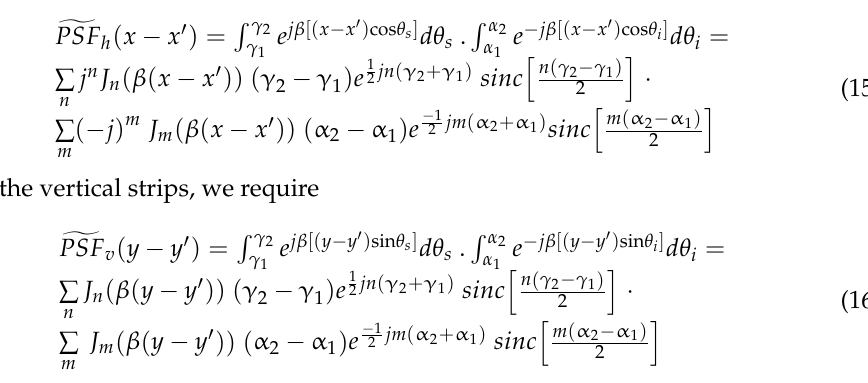
Figure 7. The geometry of the square ID.